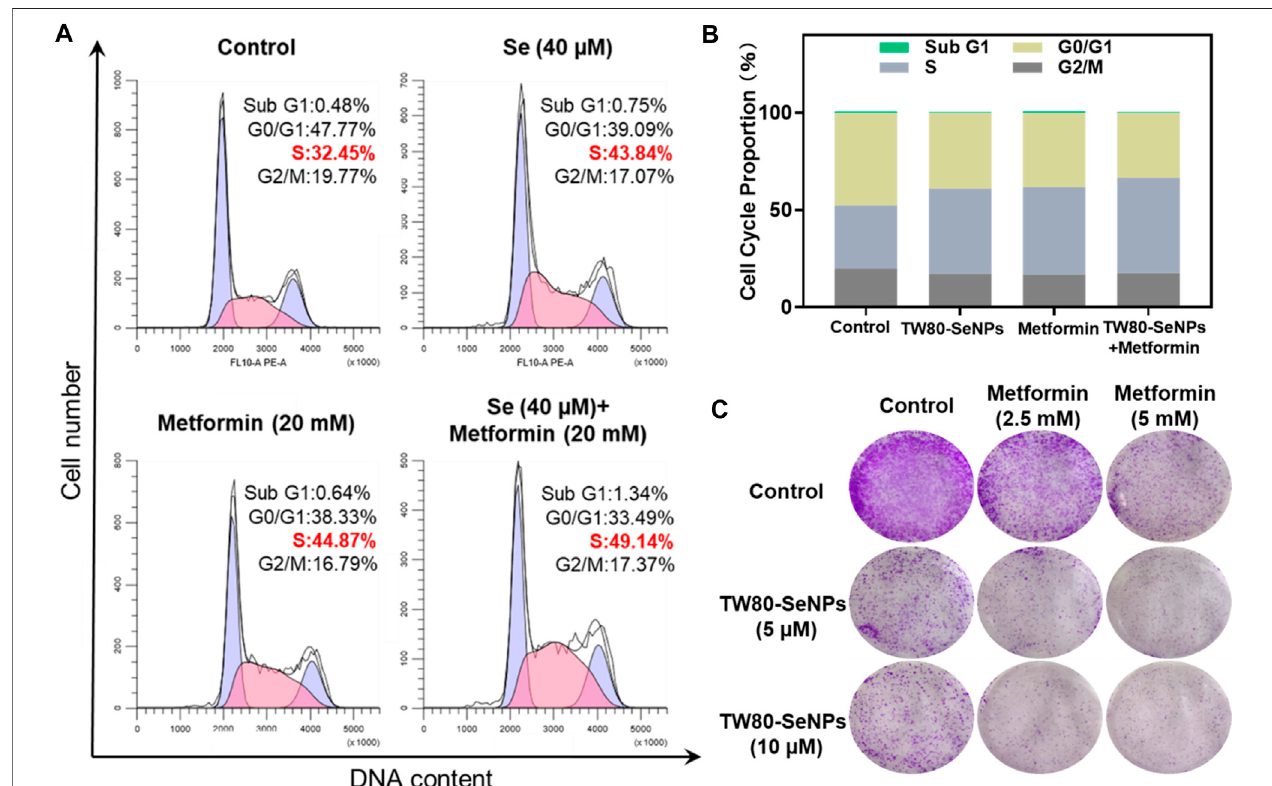
FIGURE 4 | (A , B) Flow cytometric analysis of MCF-7 cells after treatment with TW80-SeNPs and metformin for 48 h. (C) Anti-invasion effects of the treatment. Effects of TW80-SeNPs, metformin and co-administration on colony formation of MCF-7 cells at 7